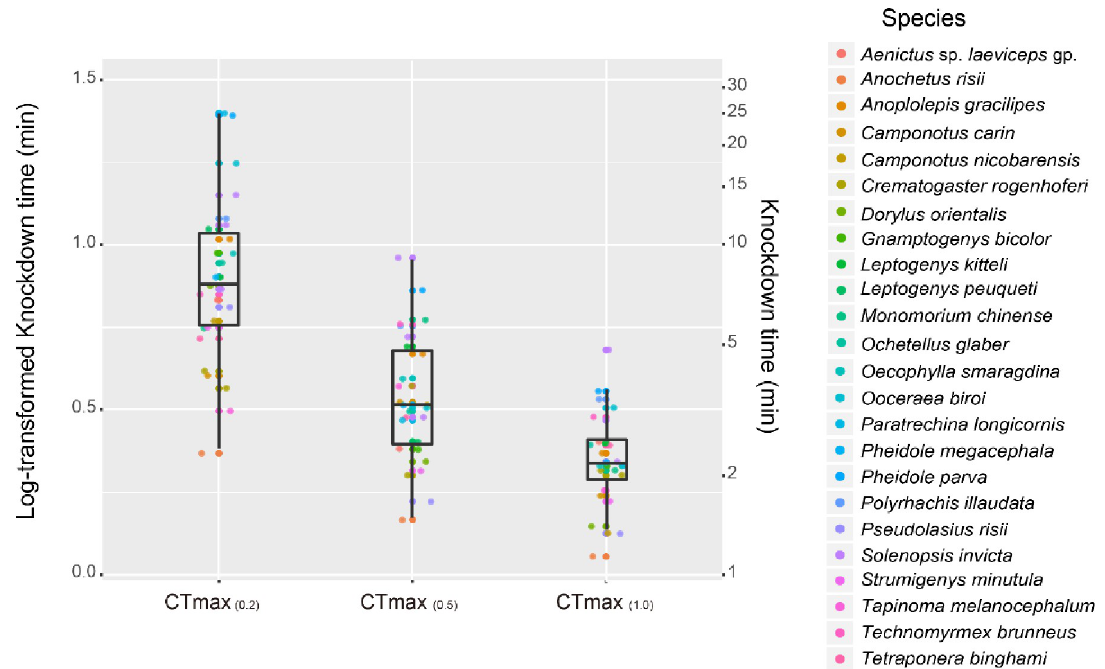
Fig 3. Results of static assays. Mean exposure duration-based tolerance values ( ± SE) of 24 ant species for three temperatures based on the values retrieved in the CT max (0.2, 0.5, and 1.0) treatments. Right y-axis refers to the duration tolerance the ants were maintaining their muscle control, and left y-axis refers to the log-transformed duration tolerance